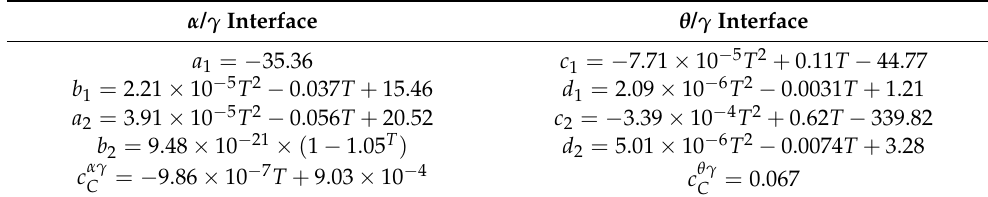
Table 1. The parameters for the thermodynamic equilibrium relationships between the solute concentrations of Fe-C-Cr